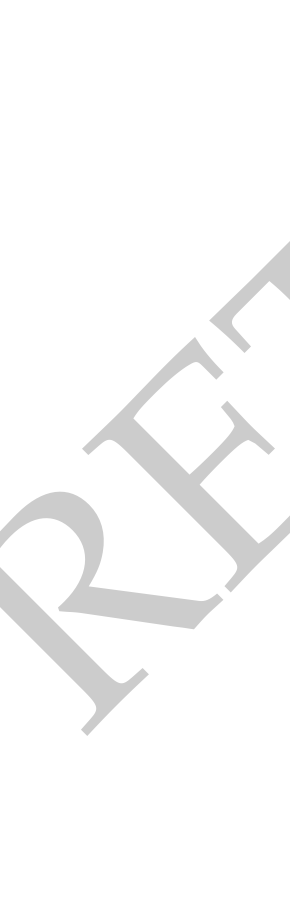
Figure 10. Images of Vero-6 cell after incubation with SARS-CoV-2 (after infection) which showed potent anti-viral activity of ZnO-NPs against SARS–Cov-2, the sheet of cells treated with ZnO-NPs showing enlarged patches around SRAS-CoV-2 cells, thus demonstrating the ability of ZnO-NPs to disinfect SARS-CoV-2 and offer a high level of inhibition to its growth.